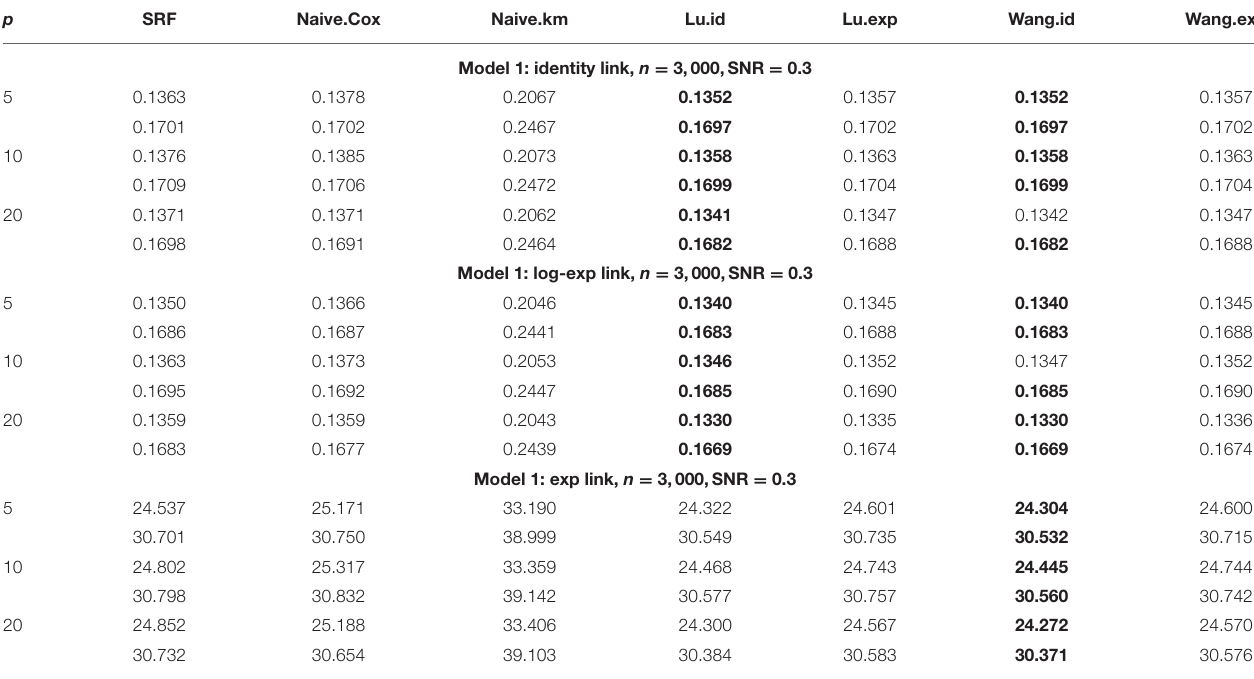
TABLE 5 | Comparison of Mean-Absolute-Error (MAE) and Rooted-Mean-Squared-Error (RMSE) for Model 1 with different link functions and the censoring distribution is mis-specificed with α = 1.5. p